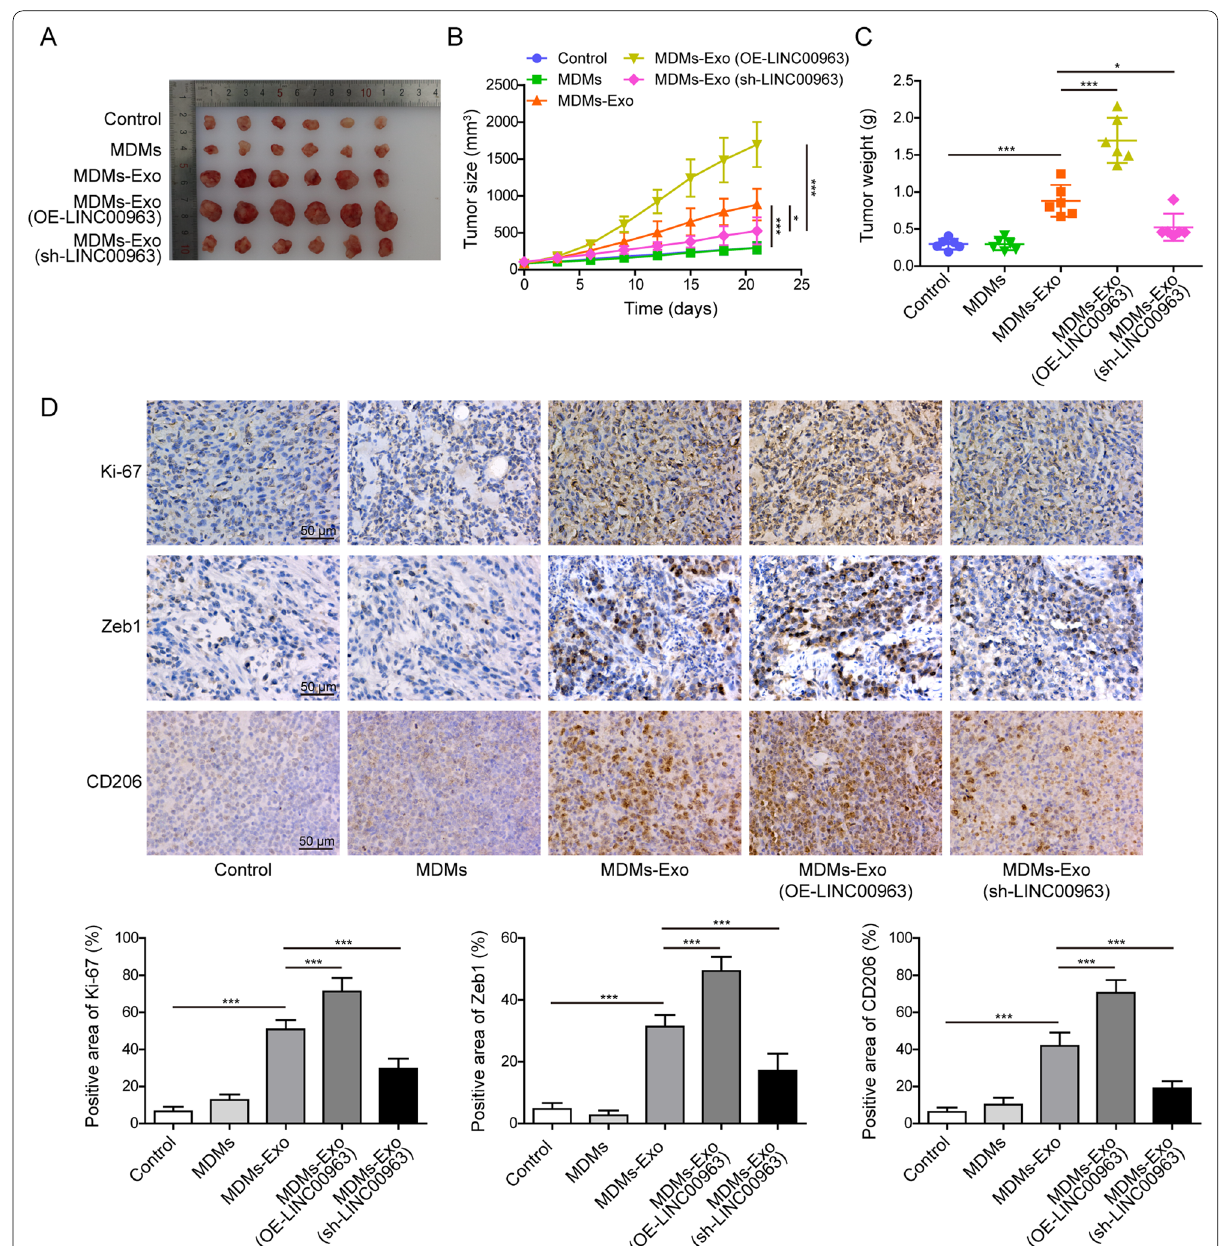
Fig. 9 Macrophages pre-conditioned with exosomal LINC00963 promoted LUAD growth and metastasis in vivo. A549 cells, together with macrophages pre-treated with exosomes isolated from indicated A549 cells, were subcutaneously injected into nude mice. Photographs ( A ), growth curve ( B ), and weight ( C ) of xenografts from indicated groups. D Immunohistochemistry staining of Ki-67, Zeb1, and CD206 from indicated xenograft tumors. Scale bar: 50 μm. * P < 0.05 and ***P <